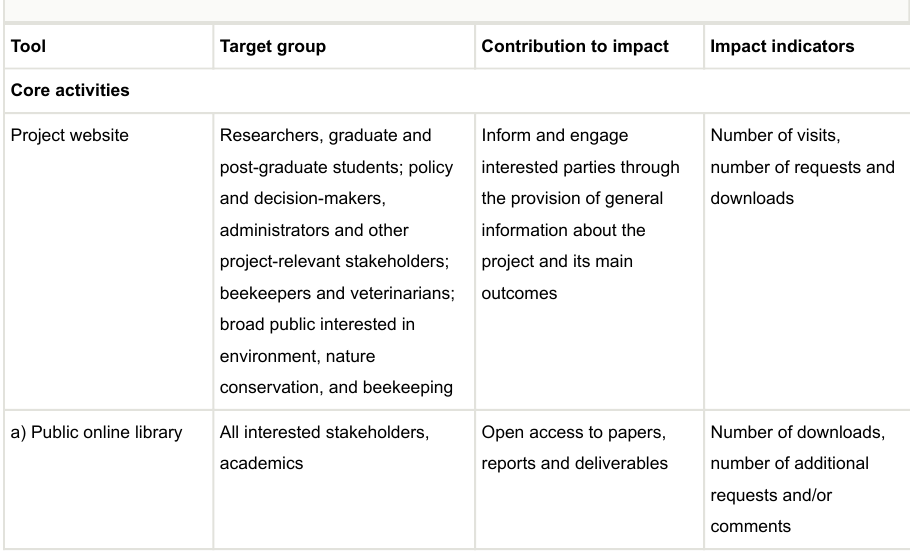
Overview of the B-GOOD communication